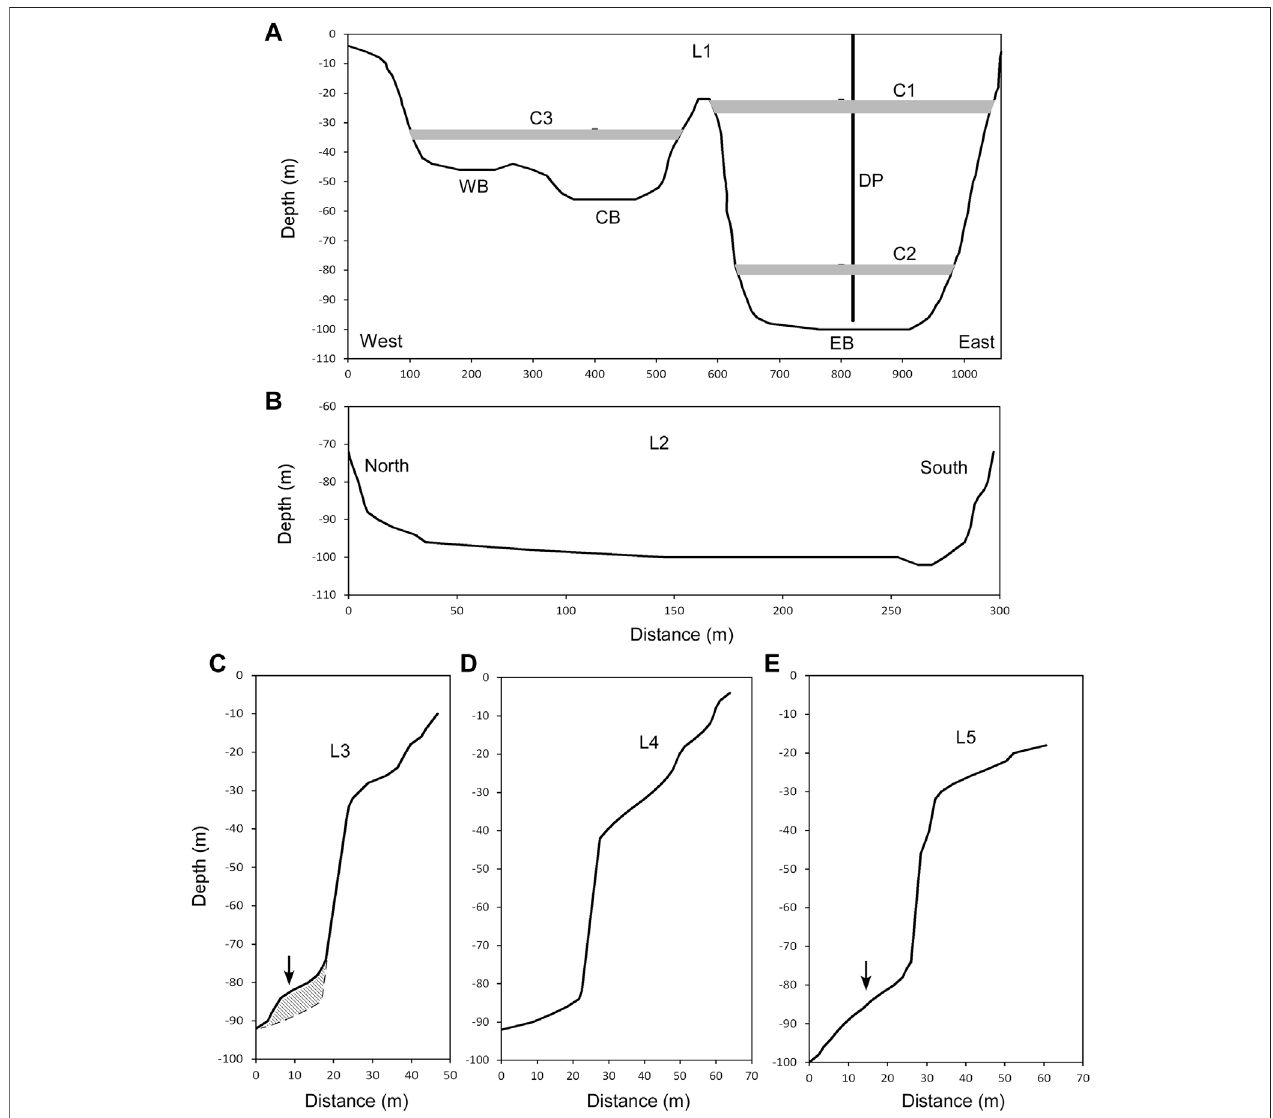
FIGURE3| CrosssectionsinLakeMonoun. (A) CrosssectionalongL1in Figure2 .C1istheshallowchemoclinein2003.C2andC3arethechemoclinesin2015. DPisanarti fi cialdegassingpipewith97mlength. (B) CrosssectionalongL2in Figure4 . (C) CrosssectionalongL3in Figure4 .ThearrowindicatesthepositionofM1. The shaded area indicates the body of M1. (D) Cross section along L4 in Figure 4 . (E) Cross section along L5 in Figure 4 . The arrow indicates the position of M2.